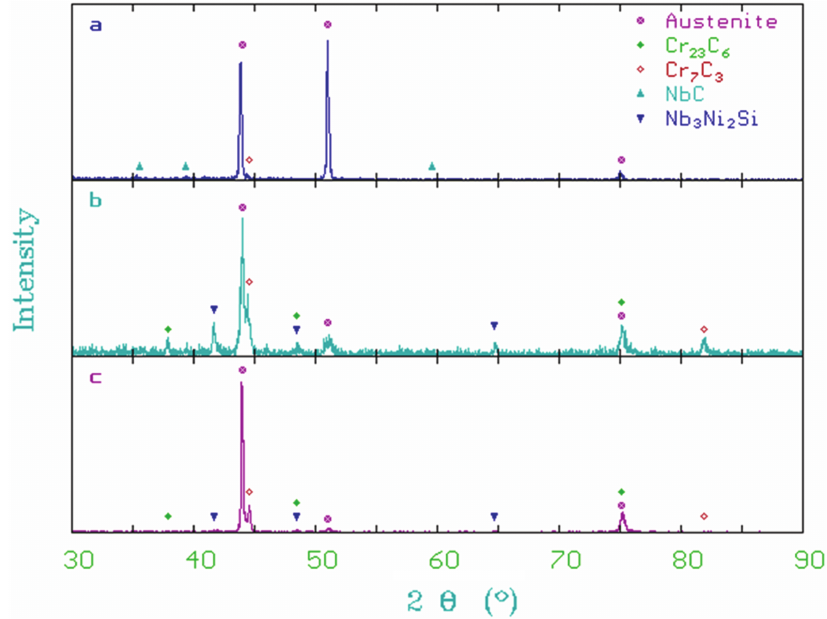
Figure 8: X-ray diffraction spectra in the as-cast (a) and aged for 500 (b) and 1000 h